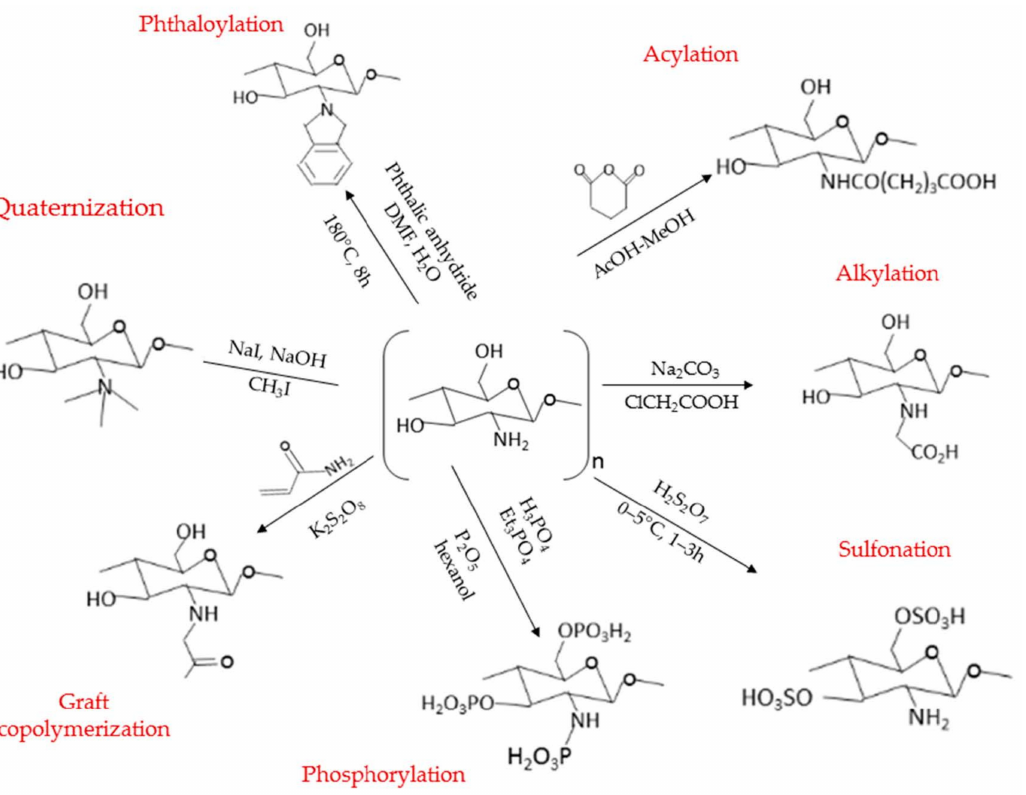
Figure 2. The various modification routes of chitosan (CS). Figure and reaction conditions were adapted from the study of Sajid et al., with modifications